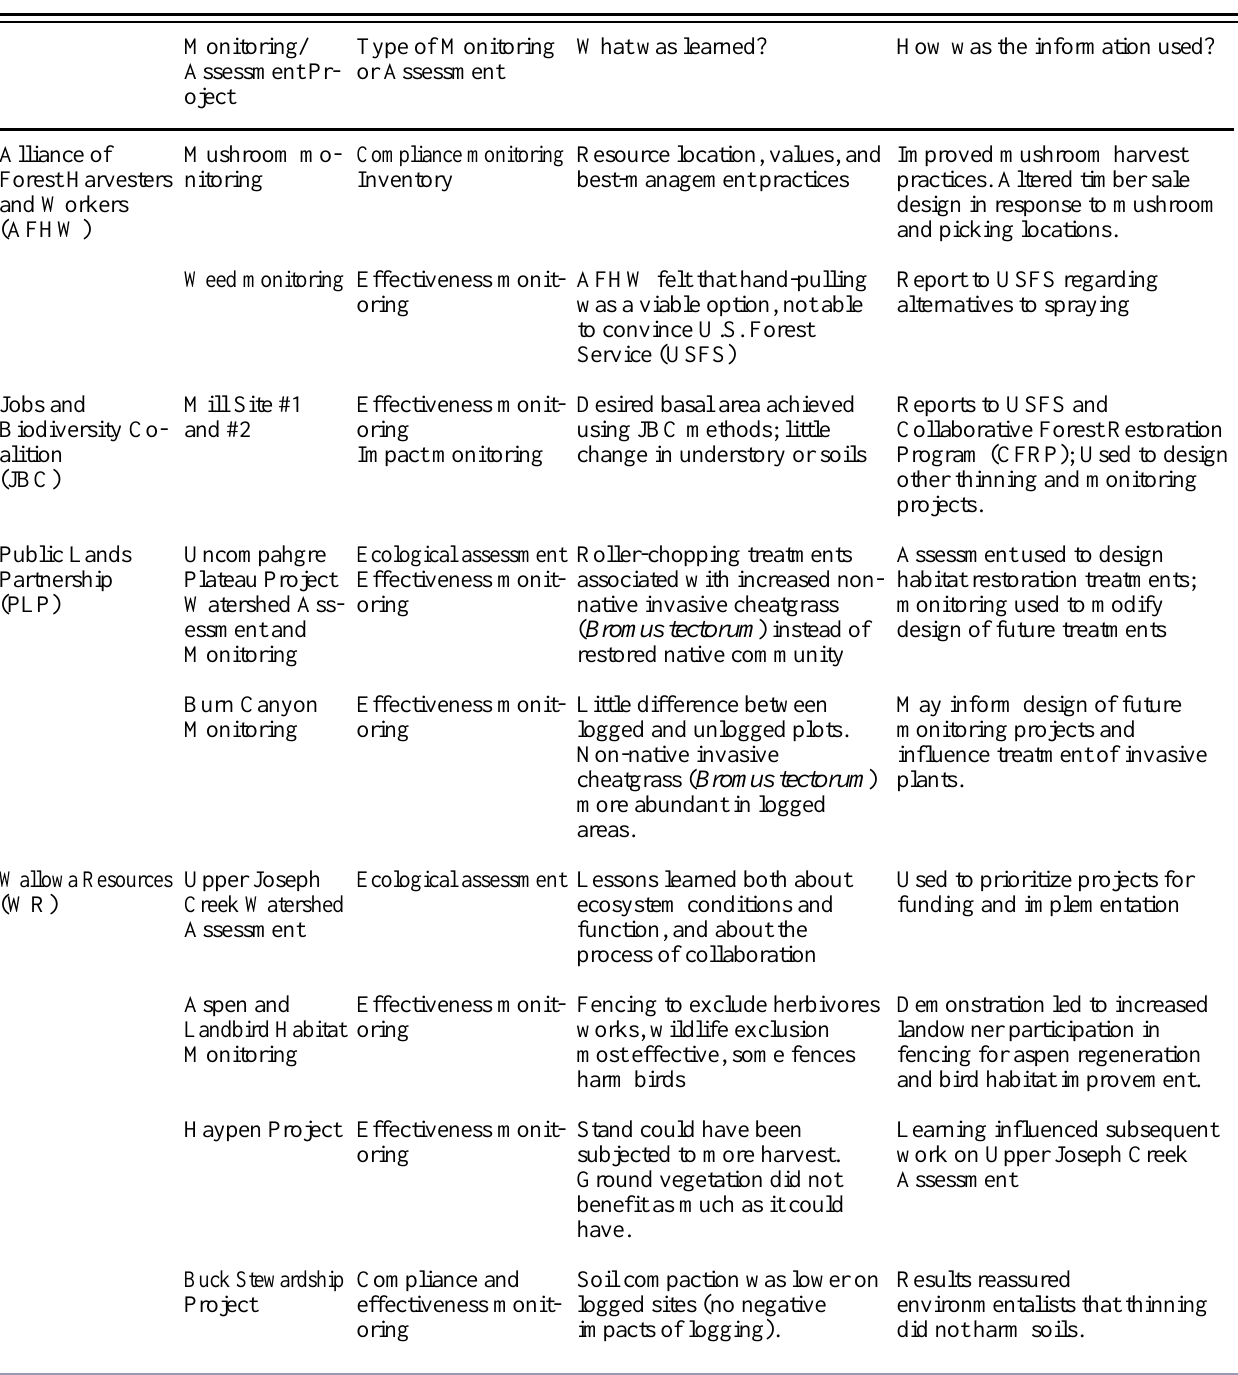
Table 2. Type of ecological monitoring or assessment, ecological learning, and application of monitoring results for 18 collaborative or community-based monitoring projects conducted by five community-based forestry organizations in the western